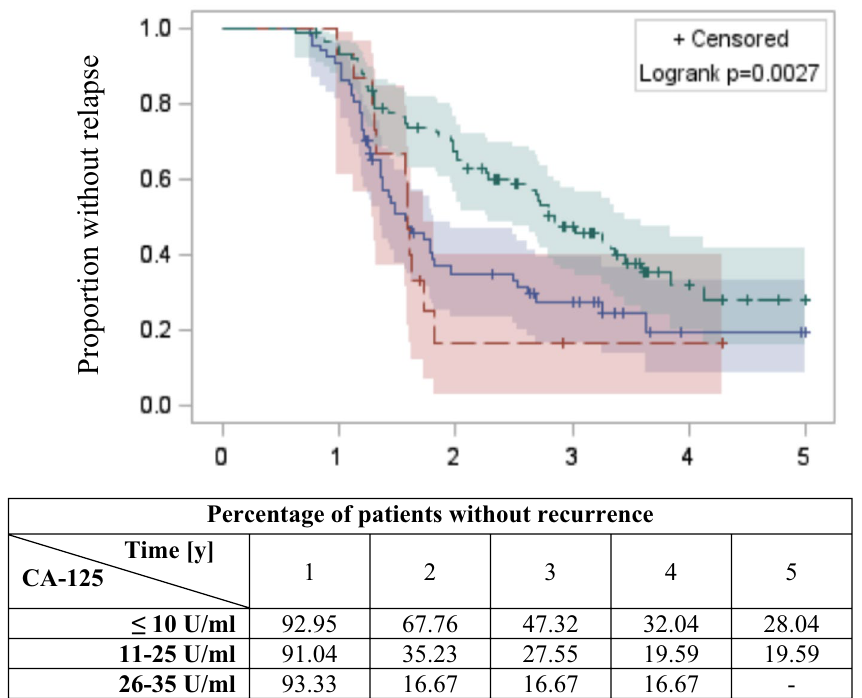
Figure 3. Kaplan–Meier curves of PFS for patients with different CA-125 nadir levels - green ≤ 10 U/ml (n = 86); blue 11–25 U/ml (n = 67); and red 26–35 U/ml (n = 15). A significant difference in PFS was achieved based on the log-rank test ( p < 0.05).